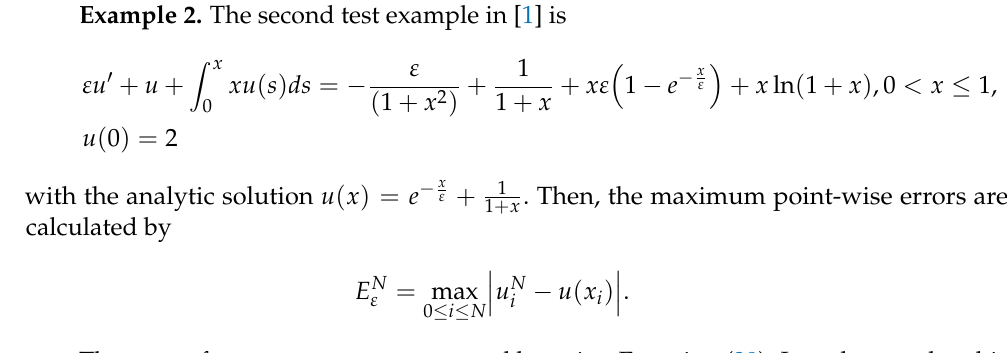
N = 64. ( a ) Grid iteration process, ( b ) Numerical solution of u ( x ) N = 64.